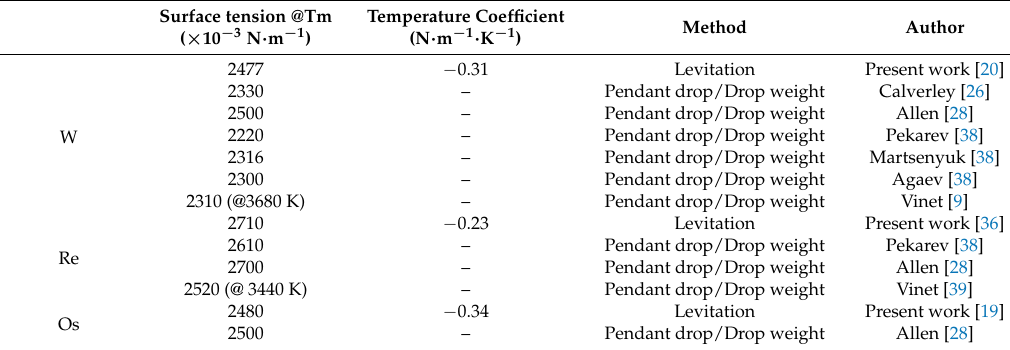
Table 3. Measured surface tension of W, Re, and Os.